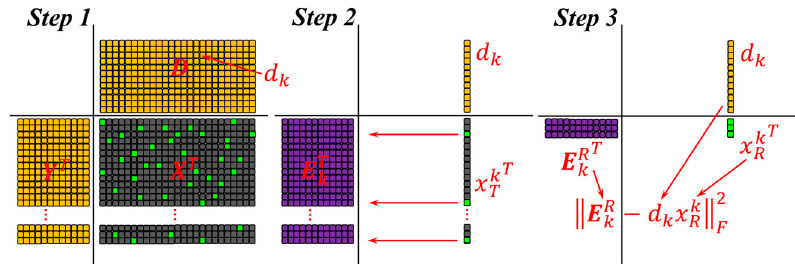
Figure 1. Key steps in K-SVD dictionary learning.